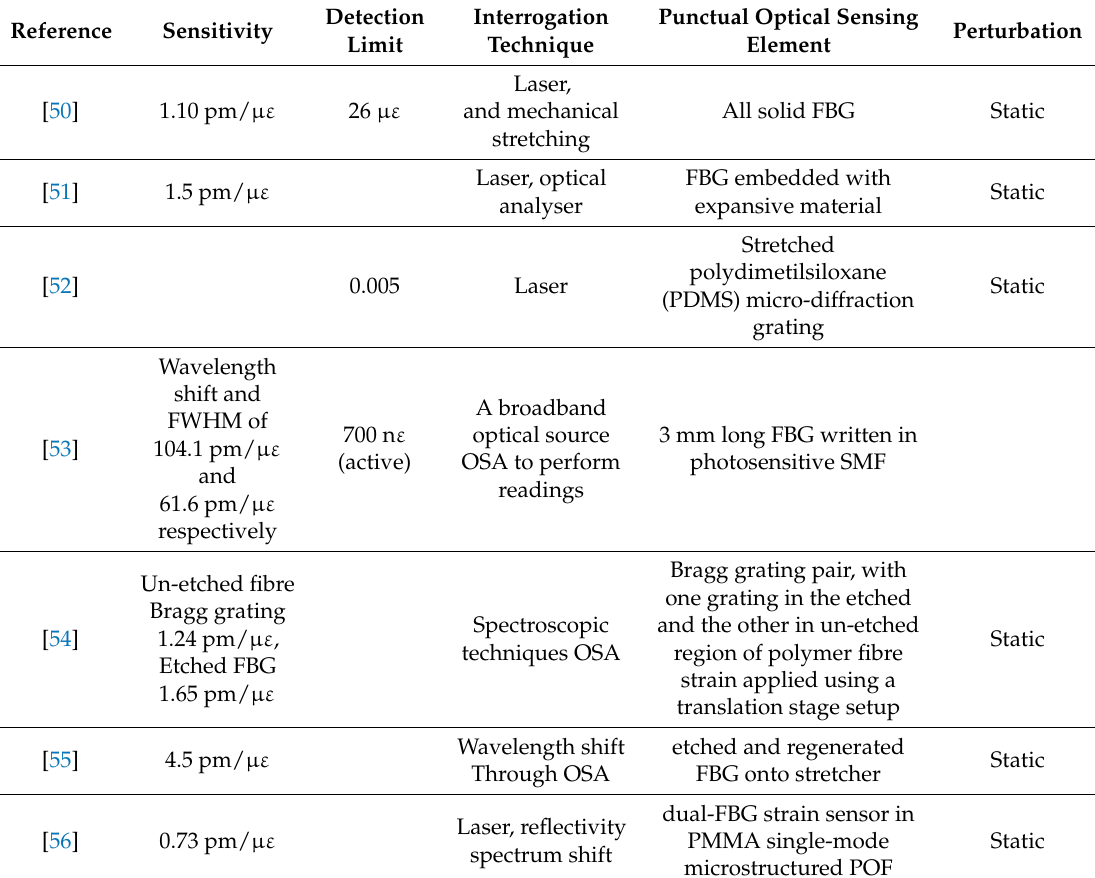
Table 1. Figures of merit and features of some examples of static strain